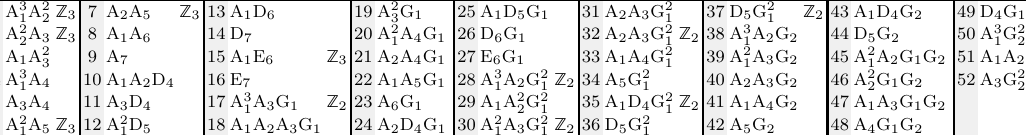
Table 6 . Algebras of maximal rank for the heterotic Z 3 triple.